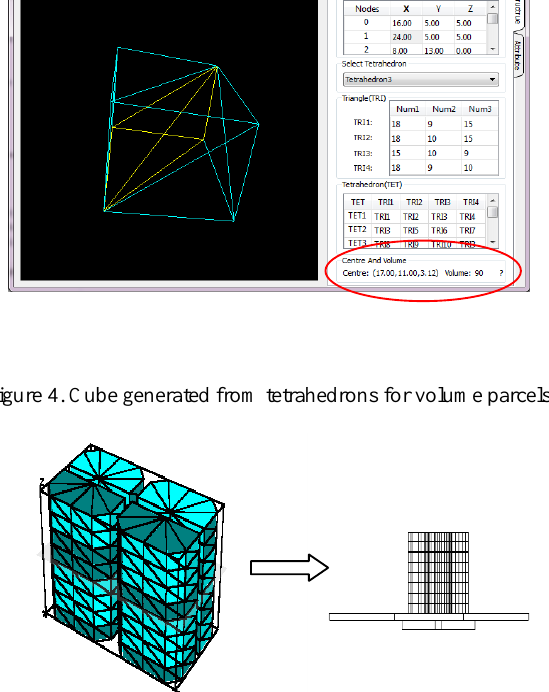
Figure 5. Tetrahedral mesh degenerated to 3D volume spaces Figure 6 is the graphics user interface (GUI) showing the wireframe and additional polygons generated for texturing. In this research, indoor navigation has not been explored.